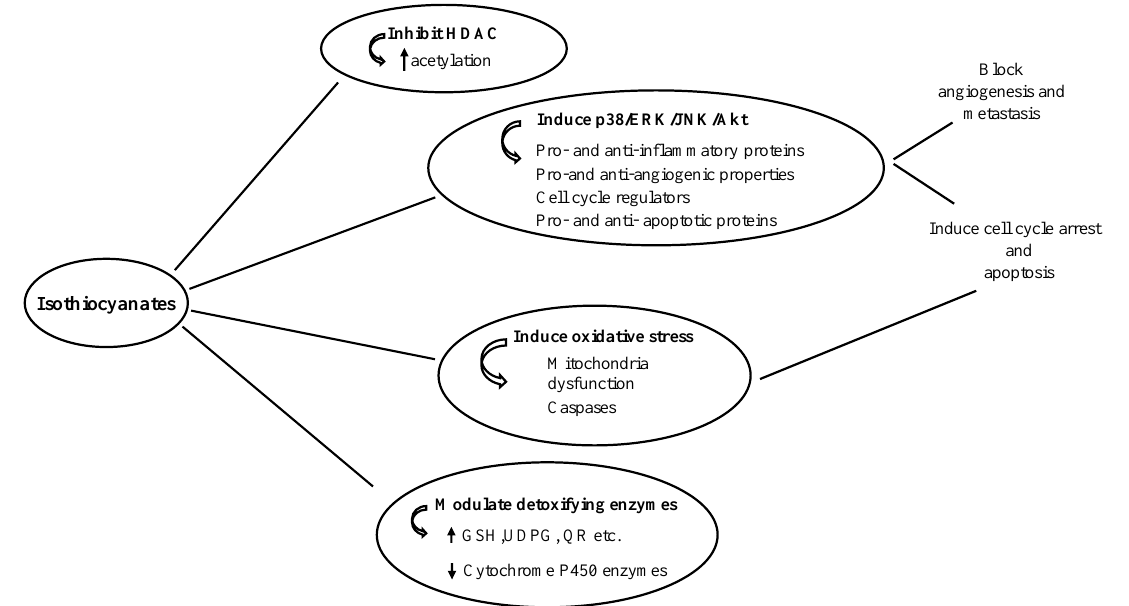
Figure 3. Schematic representation of the proposed molecular pathways targeted by isothiocyanates (ITCs), glutathione (GSH), uridine 5 (cid:48) -diphospho-glucuronosyltransferase (UDPG), quinone reductase